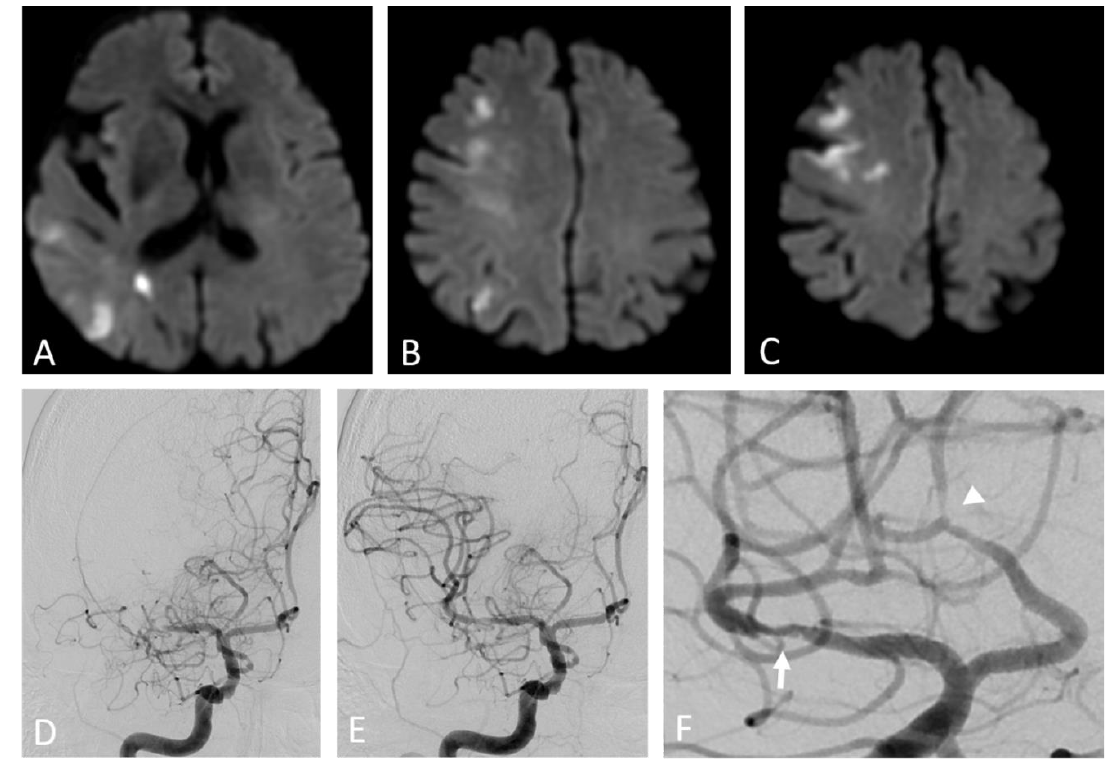
Figure 2. Selective angiography of the left coronary artery. Severe focal atherosclerotic narrowing of the proximal segment of left anterior descending coronary artery.